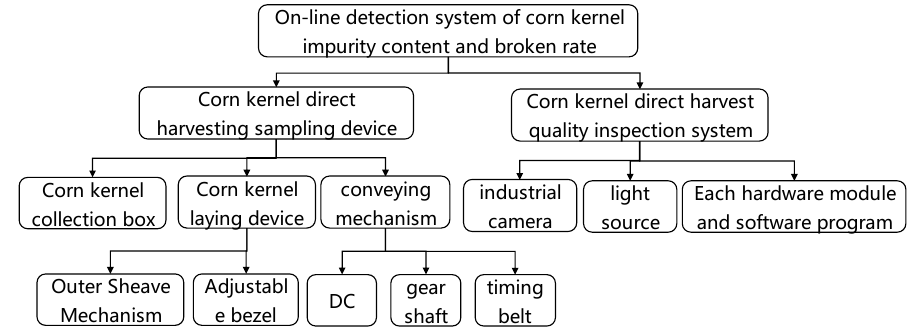
Figure 1. The structure of the monitoring system for harvested corn grains with impurities and breakage rates.